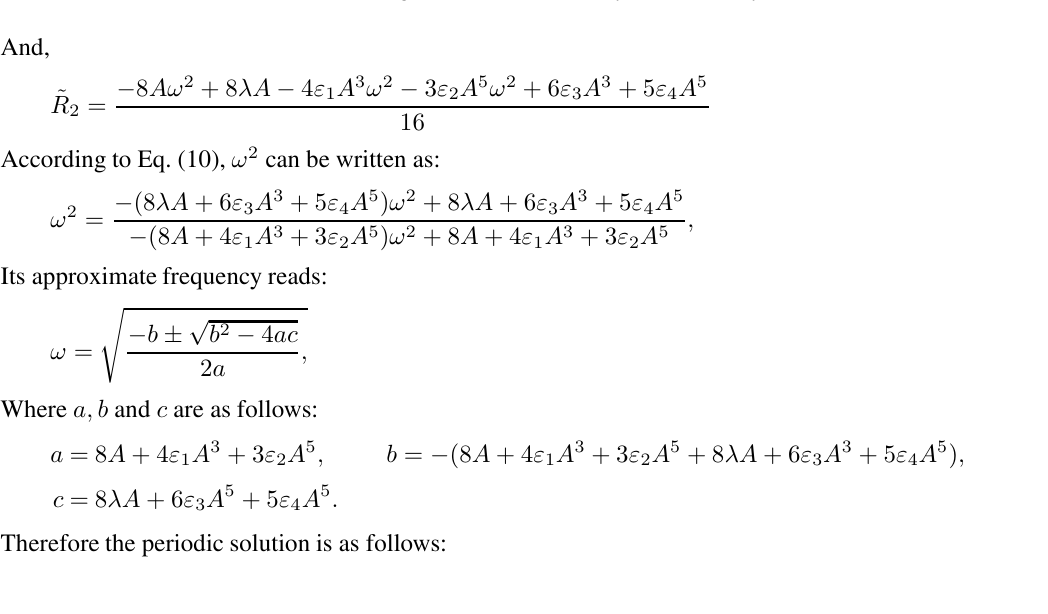
Fig. 6. A sketh of the beam system under